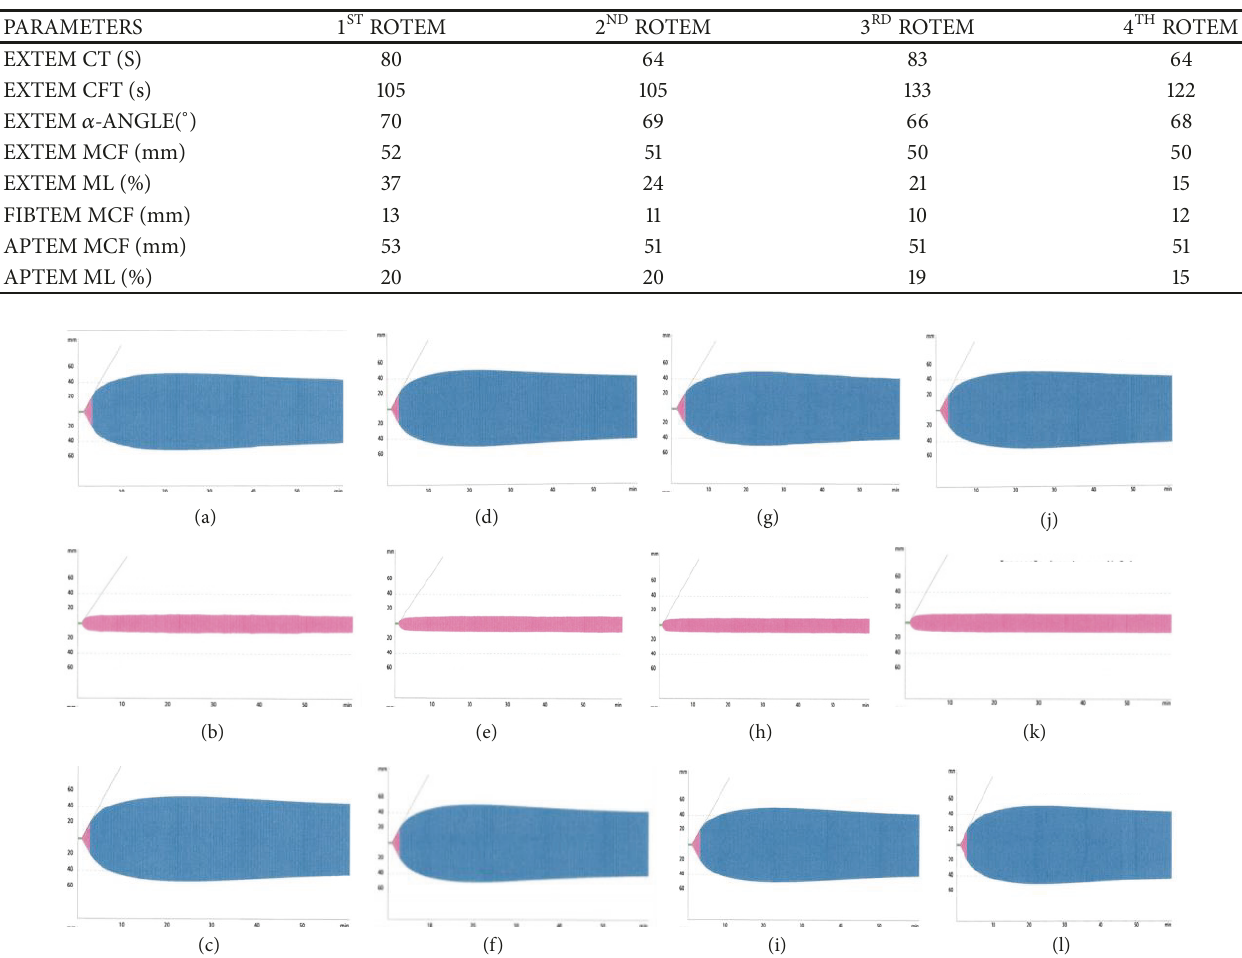
Figure 1: Sequential thromboelastometry (ROTEM). ((a), (b), and (c)) Thromboelastometry analysis at the hospital admission ((a) EXTEM, (b) FIBTEM, and (c) APTEM). ((d), (e), and (f)) Second thromboelastometry analysis performed after Tranexamic Acid administration ((d) EXTEM, (e) FIBTEM, and (f) APTEM). ((g), (h), and (i)) Third thromboelastometry analysis performed after additional administration of Tranexamic Acid ((g) EXTEM, (h) FIBTEM, and (i) APTEM). ((j), (k), and (l)) Thromboelastometry analysis performed after factor XIII concentrate (Fibrogammin (cid:2) P, CSL Behring, Marburg, Germany) ((j) EXTEM, (k) FIBTEM, and (l)